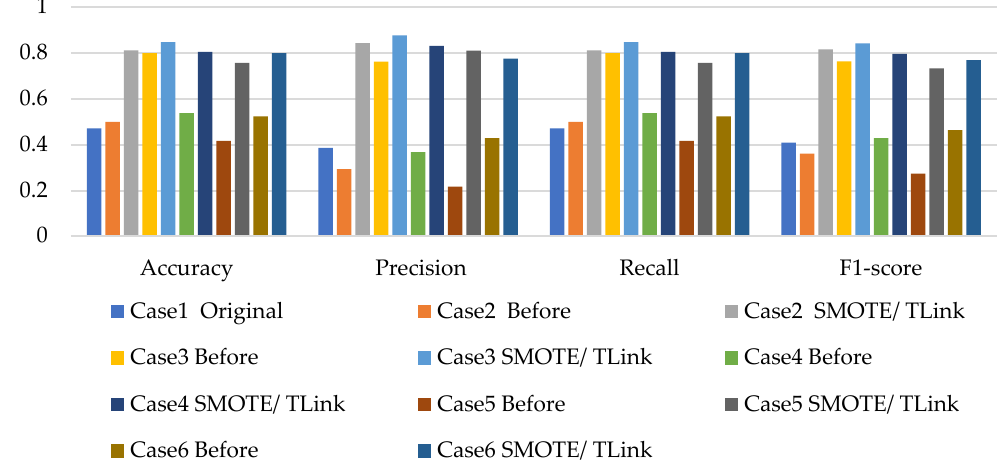
Figure 13. Simulation performance of k-NN classification with SMOTE/T-link.